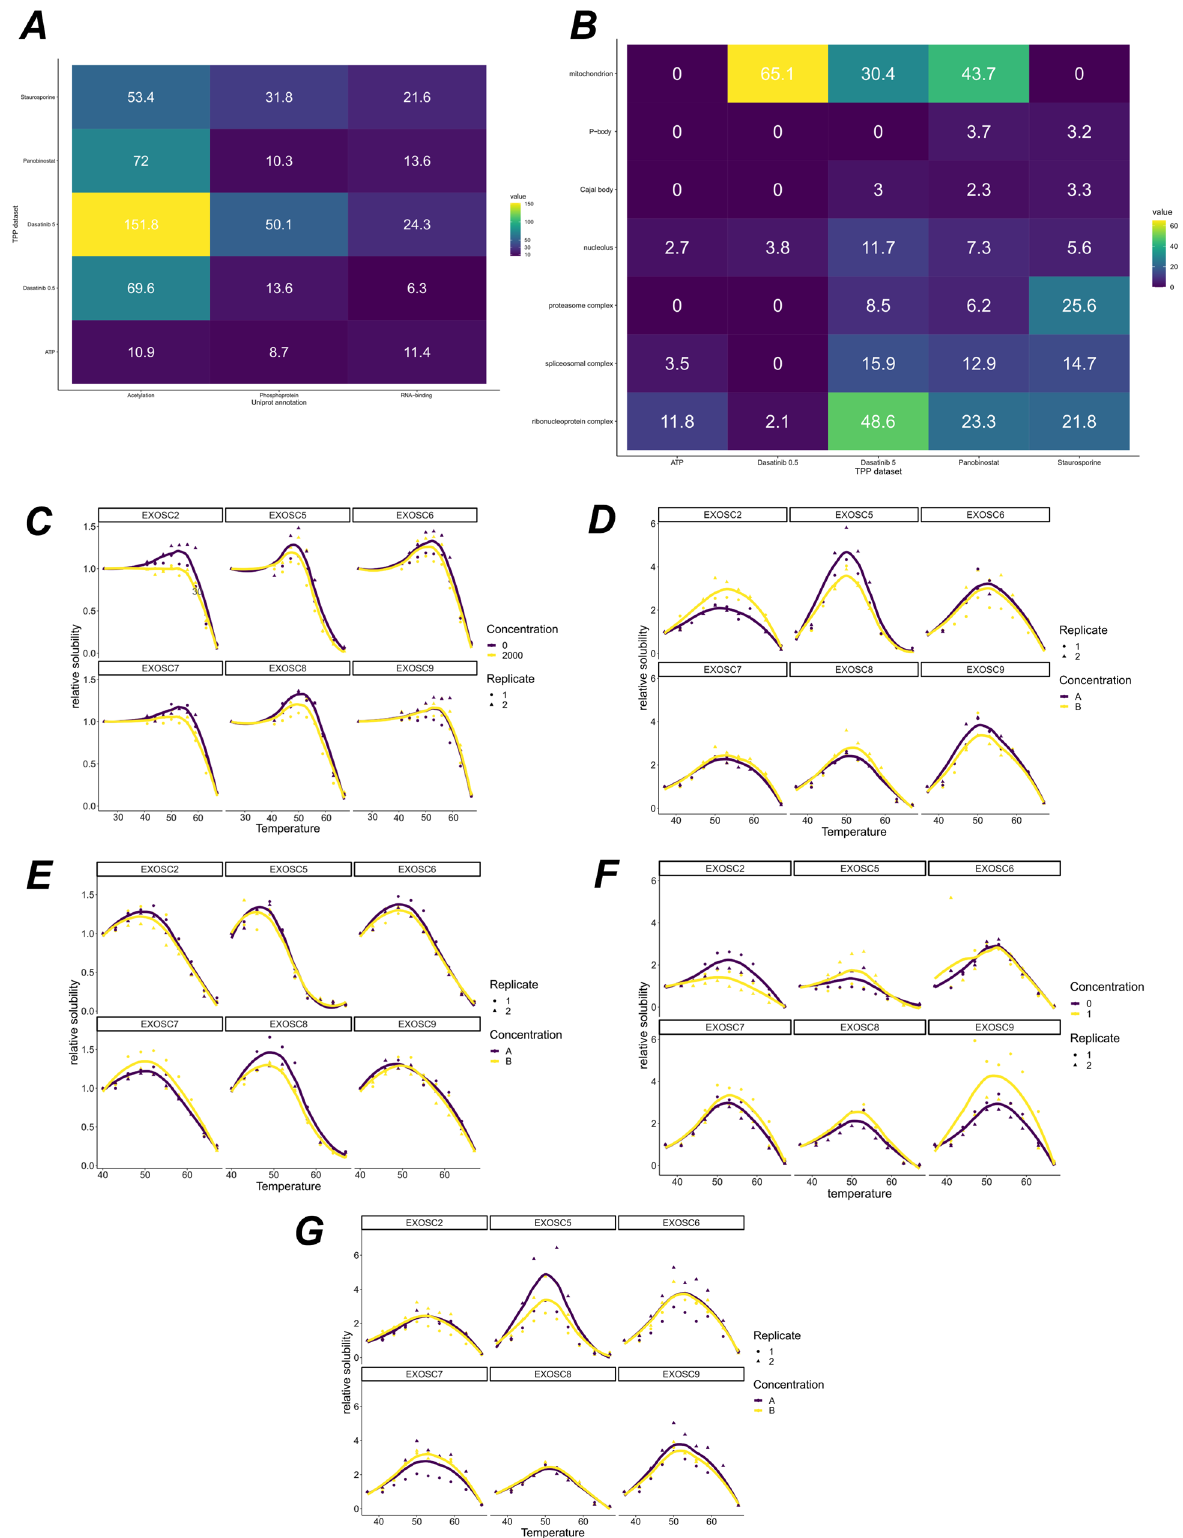
Fig. 5 Enrichment analysis of protein deviating from sigmoid behaviour. A Uniprot key term enrichment analysis. A tile plot show − log 10 of the p -values for each of the terms for the 5 human datasets. B GO CC enrichment analysis. A tile plot showing − log 10 of the p -values for each of the terms for the 5 human datasets. C – G Melting pro fi les of the proteins from the EXOSC complex, across the 5 human datasets, C ATP dataset ( D ) Dasatinib 5 dataset ( E ) Staurosporine dataset ( F ) Panobinostat dataset ( G ) Dasatinib 0.5 dataset. Statistics derived from two biological replicates, for each of two conditions each with 10 measure